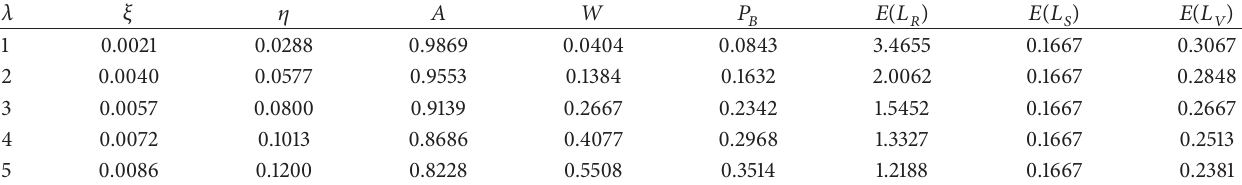
Table 3: Main reliability indices of production line for different virus arrival rate 𝜆 with (𝑟, 𝜃,𝛼, 𝛽) = (15,6, 0.35, 14) .